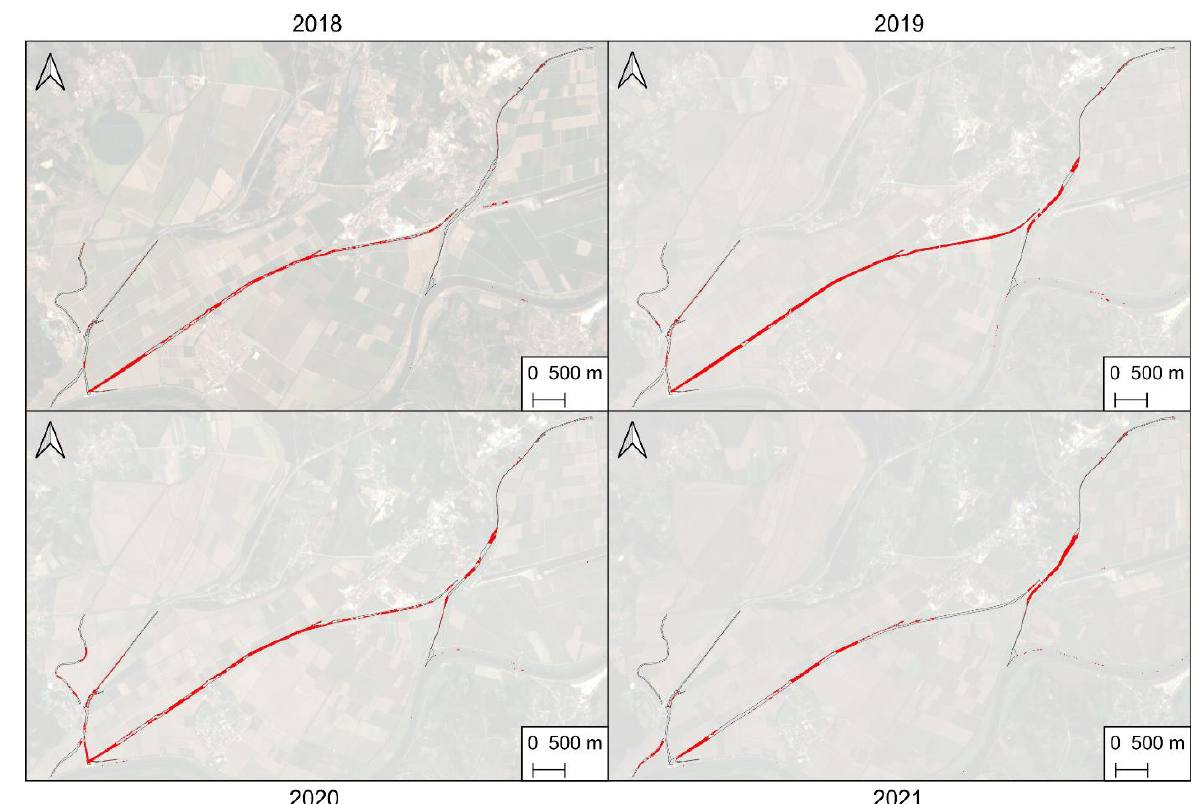
Figure 5. Spatial distribution of water hyacinth in the study area in October of 2018, 2019, 2020, and 2021.